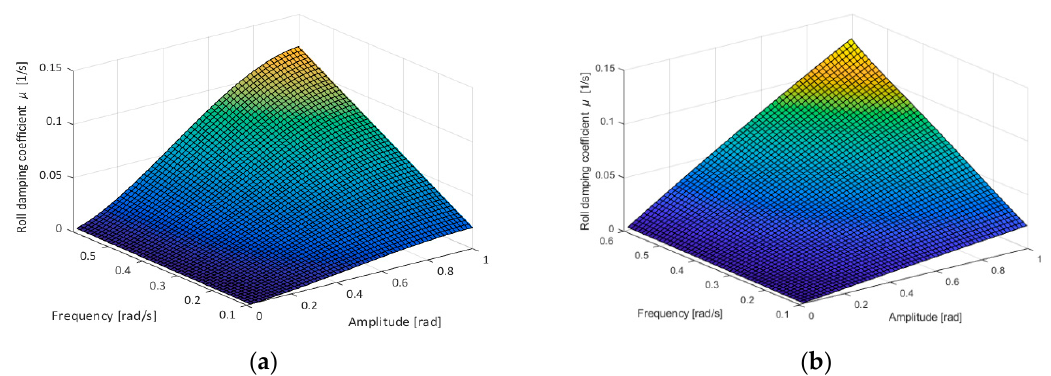
Figure 3. Damping coefficients for the LNG carrier ( T = 7.50 m, GM 0 = 4.00 m, C B = 0.813, C M = 0.972, bilge keel: l BK = 40.00 m ≈ 0.15 L PP , b BK = 0.50 m) calculated according to the simple Ikeda’s method ( a ) and next approximated using coefficients α ( ω ), β ( ω ) and γ ( ω ) in Equation (11) ( b ).